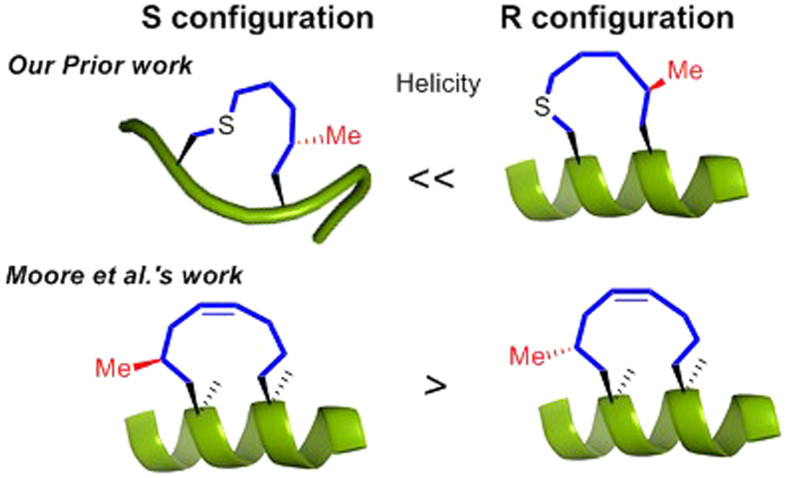
On-tether chiral centres influence the secondary structure of the peptide.